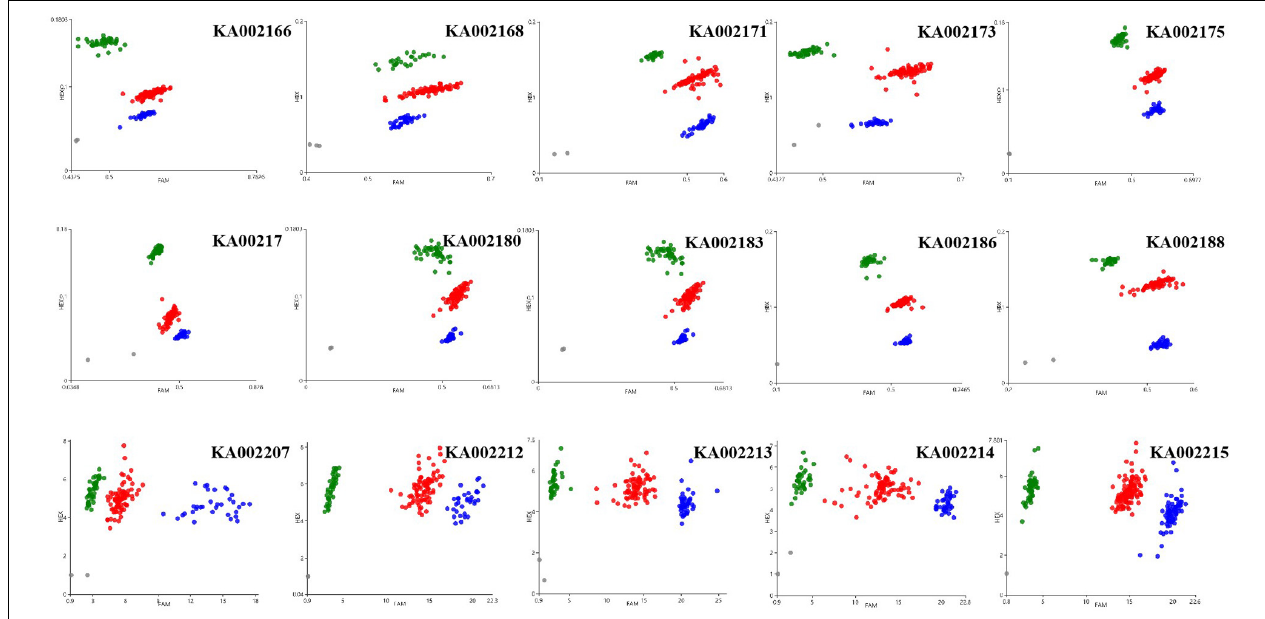
FIGURE 3 | Results of genotyping using the Kompetitive Allele Specific PCR (KASP) assay. Scatter plots for selected KASP assays showing clustering of varieties on the X- (FAM) and Y- (HEX) axes. The green and blue dots represent the homozygous F 2 lines and the red dot represents heterozygous F 2 lines from the mapping population of the wm-6 × 12D-1 cross. The gray dots represent the NTC (non-template control).